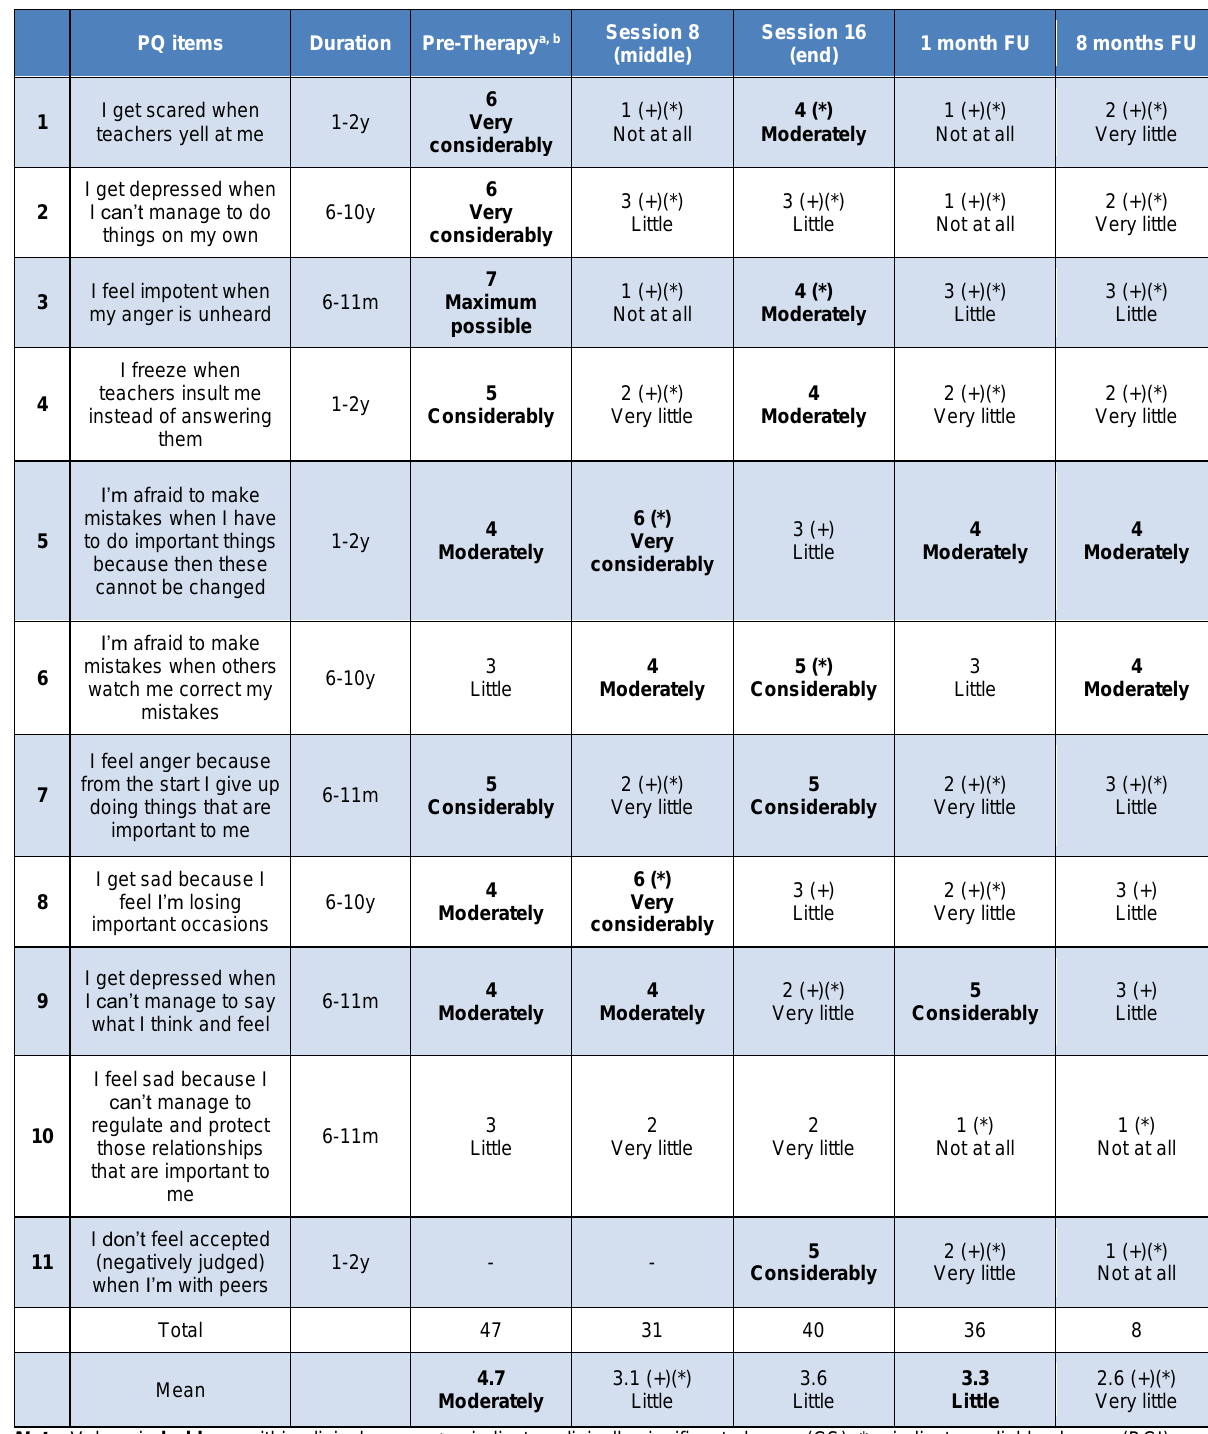
Table 2: Giovanni’s personal problems (PQ), duration and